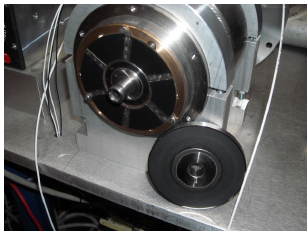
Figure 8: NDE thrust foil bearing with nonlinear stiffness character- istics that was loaded during the blower operation.